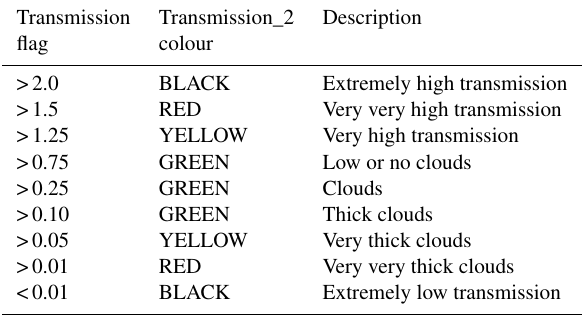
Table 4. ShicRIVM categories of atmospheric transmission normal- ized to unity for cloudless sky, and the associated colours for the Transmission_2